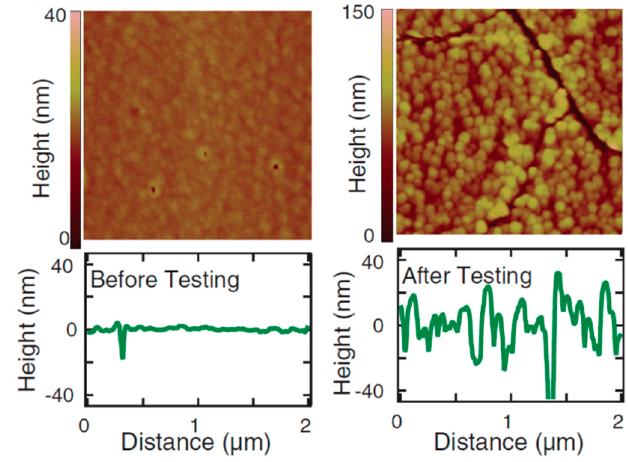
Figure 1. AFM images of 100 nm SrIrO 3 film before and after 30 h of oxygen evolution reaction (OER) performance, showing the surface rearrangement. Reproduced from [16], with permission from the American Association for the Advancement of Science, copyright 2016.